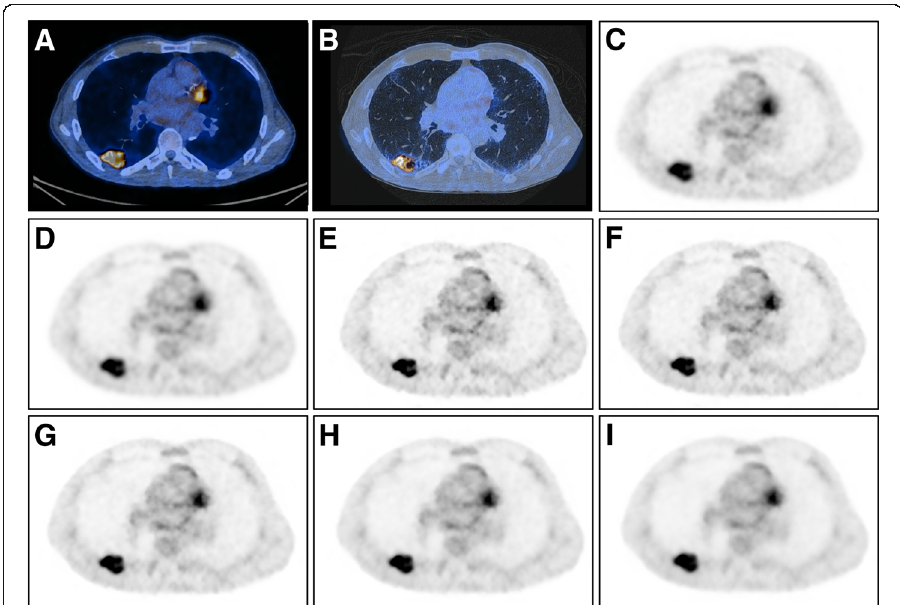
Fig. 2 Representative images of a 66-year-old man with a body mass index of 20.7 kg/m 2 and 59 kg body weight who underwent 18F-FDG PET/CT for staging of lung cancer. The patient was injected with 117.9 MBq of 18F-FDG (i.e., 2.0 MBq/kg body weight), according to the BMI-adapted dosage protocol developed for digital PET [14]. Co-registered PET/CT images ( a , b ) show a highly 18F-FDG-avid tumor in the right lower lobe, which was confirmed as adenocarcinoma after wedge resection. Axial PET images are given in c – i , showing OSEM TOF ( c ), OSEM PSF ( d ), BSREM 350 ( e ), BSREM 450 ( f ), BSREM 600 ( g ), BSREM 800 ( h ), and BSREM 1200 ( i